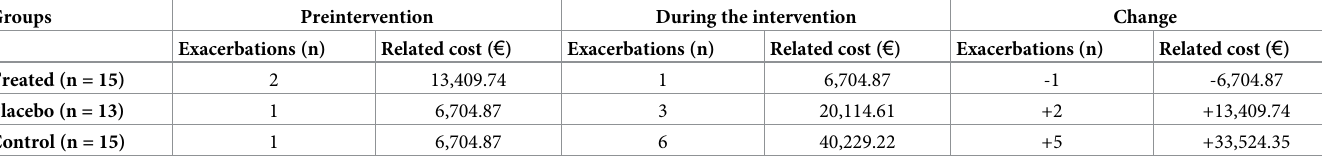
Table 3. Healthcare resources in children with cystic fibrosis according to the different groups.